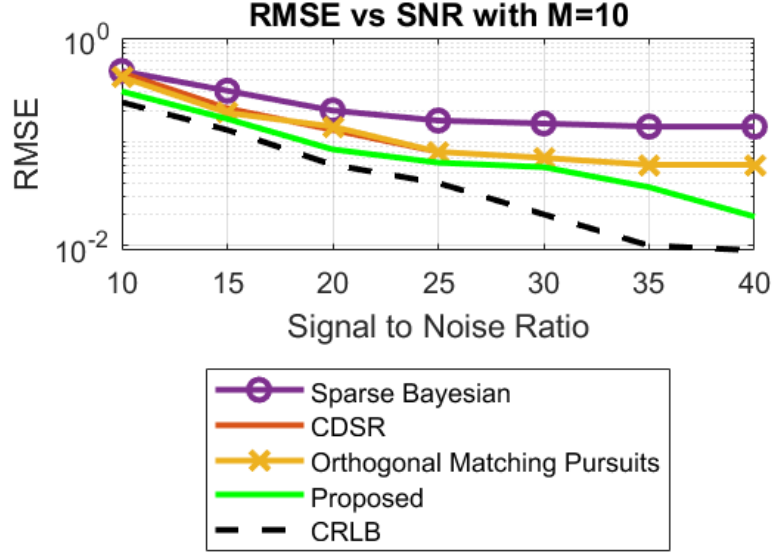
Figure 12. RMSE vs. SNR with M = 10.